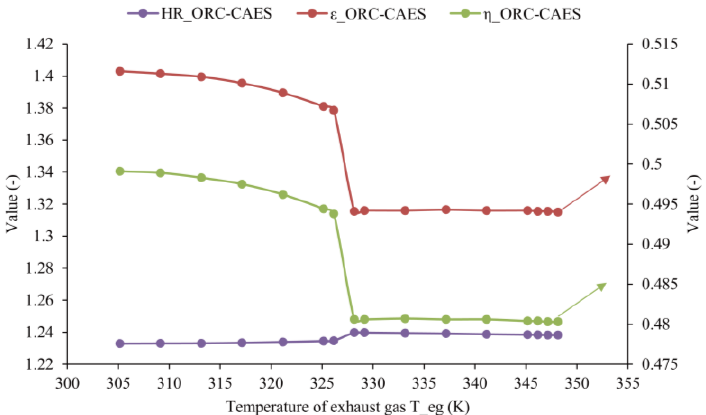
Figure 6. Effect of the outlet temperature of the exhaust gas on the performance parameters of the ORC-CAES. the